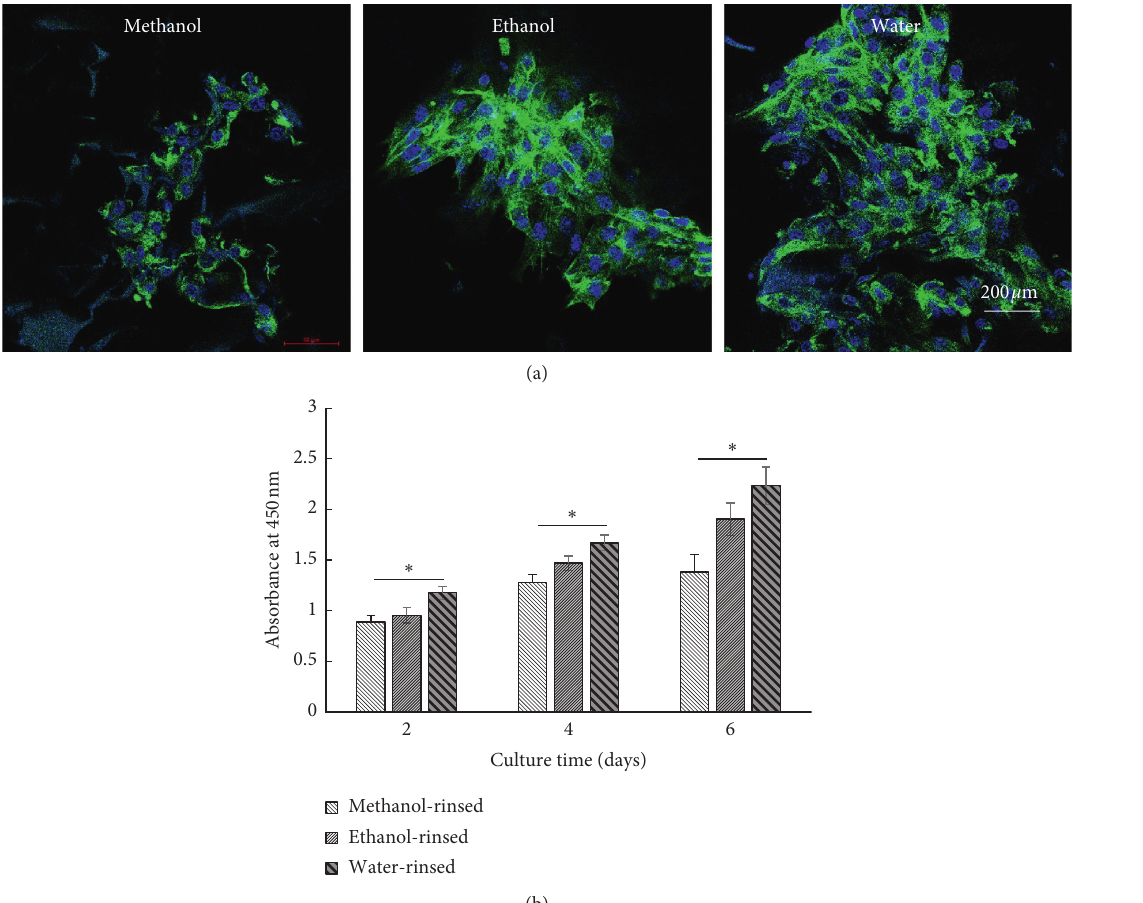
Figure 6: Confocal microscopy of BMSCs on silk scaffolds at day 4 (a) and CCK-8 assay of BMSCs proliferation on silk scaffolds ( ∗ p < 0 . 05)